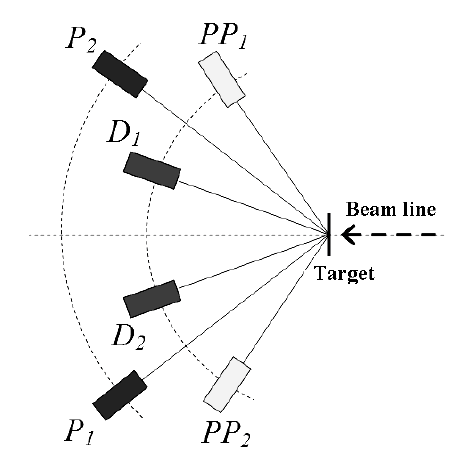
Figure 1. Layout of the counters with respect to the beam direction. D 1 , 2 , P 1 , 2 - deuteron and proton detectors, PP 1 , 2 - detectors to register the pp-quasi-elastic